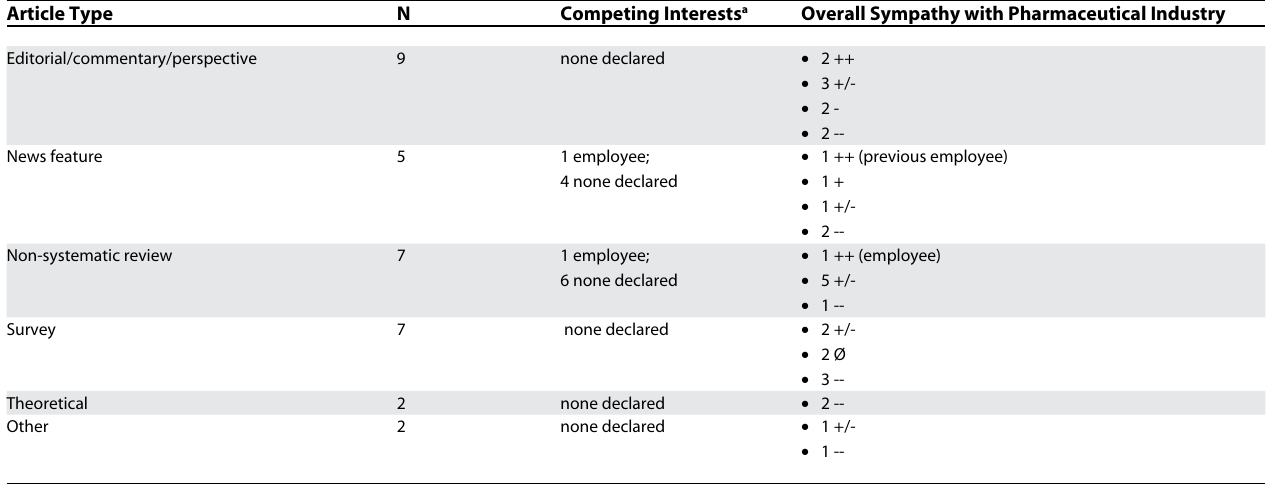
Table 2. Summary of Article Positions and Competing